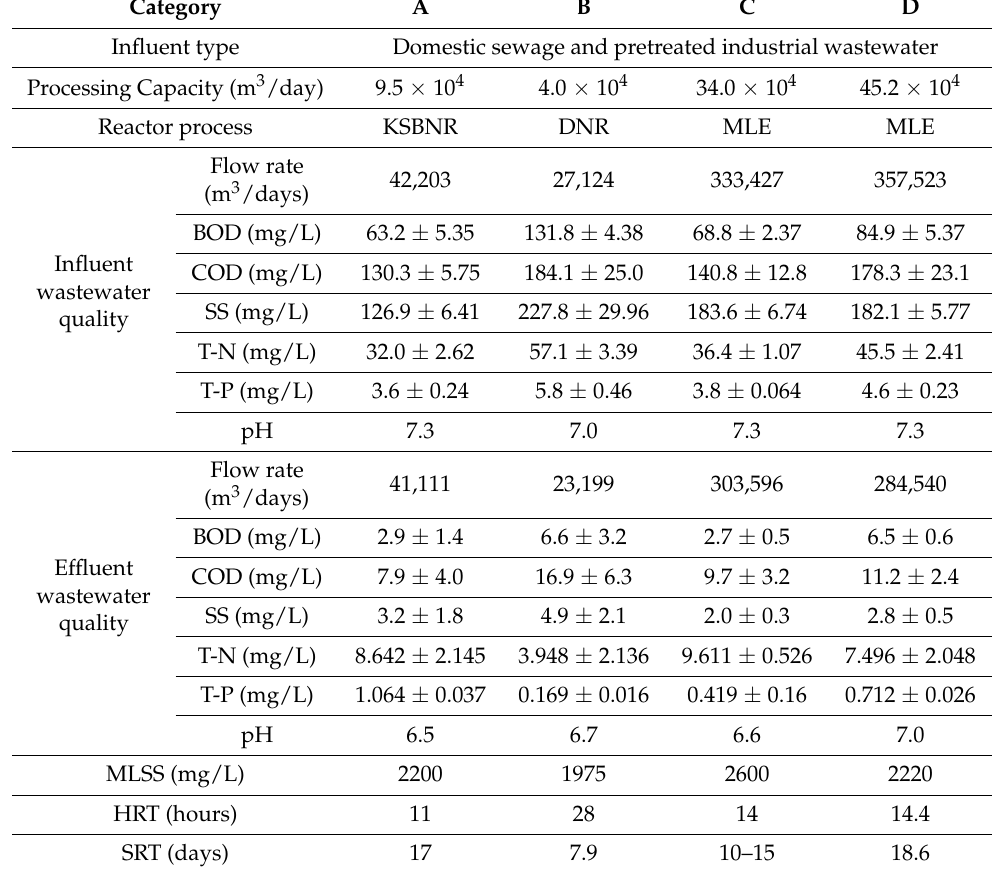
Table 1. Quality parameters of wastewater samples in